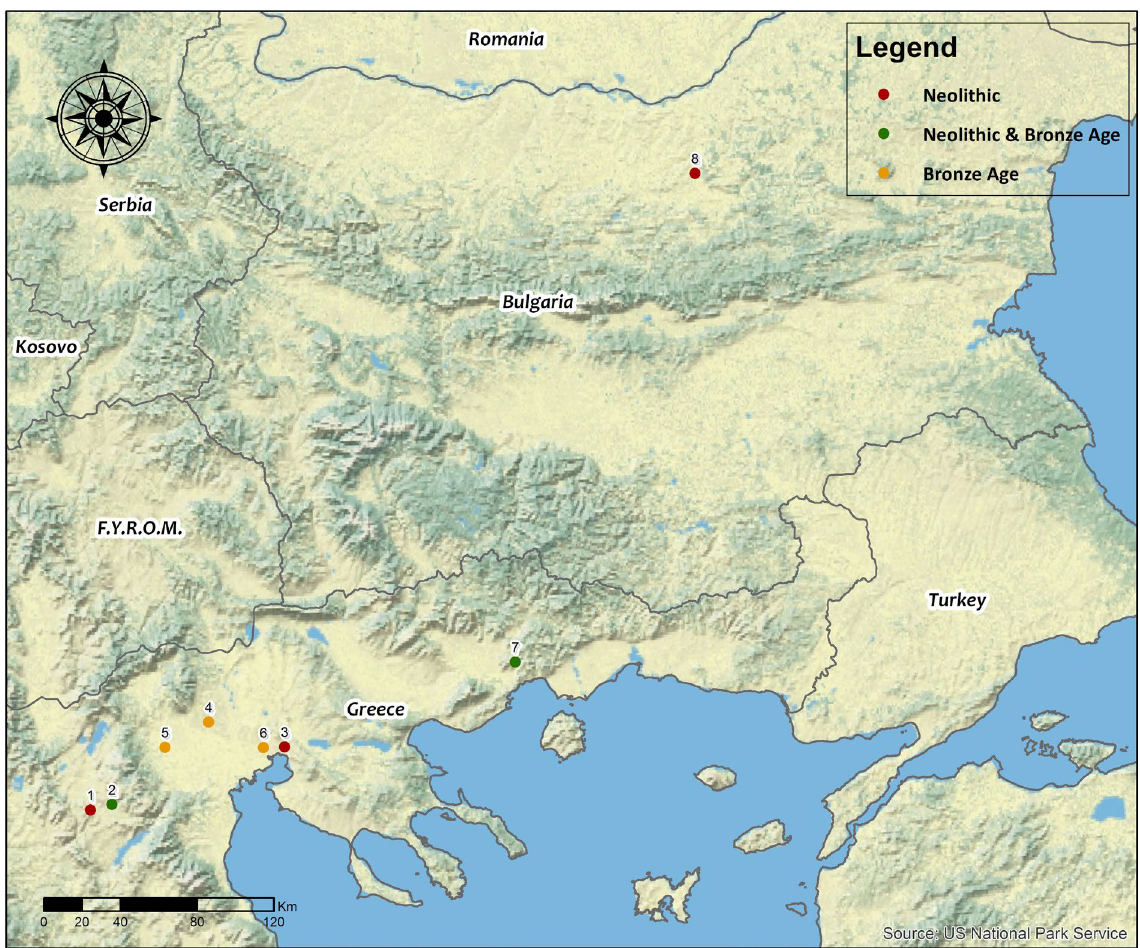
Figure 1. Sites with grinding and pounding stone tool assemblages under study in the context of Plantcult ERC project. (1) Fillotsairi-Mavropigi, (2) Kleitos, (3) Stavroupoli, (4) Archontiko, (5) Aggelochori, (6) Agios Athanasios, (7) Dikili Tash, (8) Petko Karavelovo (ERC PLANTCULT). Source: US National Park